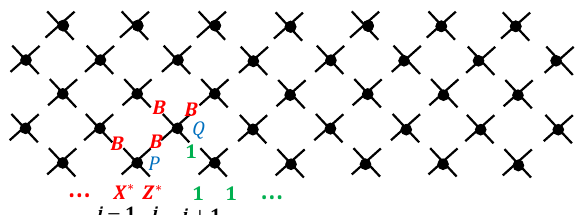
Figure 14 . Sharp light-cone growth of operators in the perfect tensor model. The unitary ˜ U at point P in the circuit acts on operators at i − 1 , i , and gives some operator which is nontrivial on both i − 1 and i . In the figure, X ∗ , Z ∗ refer to any powers of X and Z , and B to any non-trivial operator. ˜ U at Q acts on an operator which is non-trivial on site i and trivial on site i + 1 , giving an operator which is non-trivial on both i and i + 1 . By repeatedly using the fact that operators nontrivial on a single site evolve to operators non-trivial on two sites, we see that the right endpoint moves to i + ( t − 1) at time t